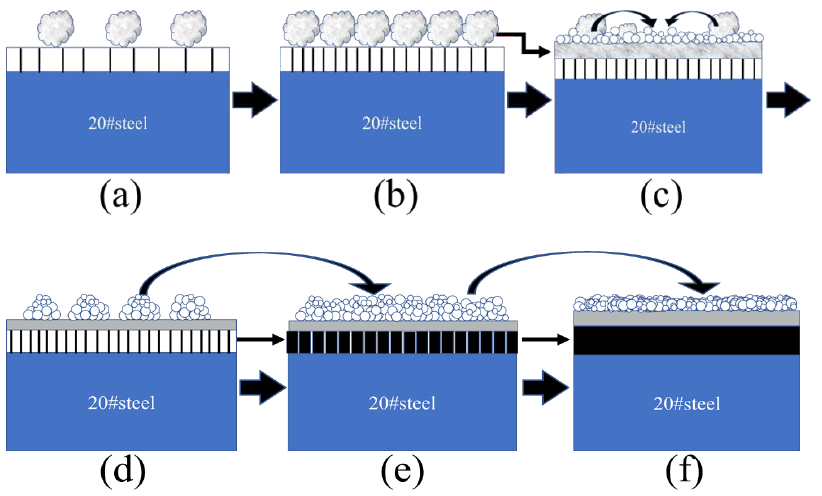
Figure 9. Schematic diagram of the formation process model of the corrosion products layer: ( a ) the loose needle and flocculent corrosion products, ( b ) the needle and flocculent corrosion products gradually densified, ( c ) the inner layer with dual-structure characteristics and the outer layer composed of spherical particles, ( d ) the outer layer with a broccoli shape formed, ( e ) the inner, middle, and outer three sub-layers were gradually densified, ( f ) the three-layer-structure characteristic corrosion products layer.